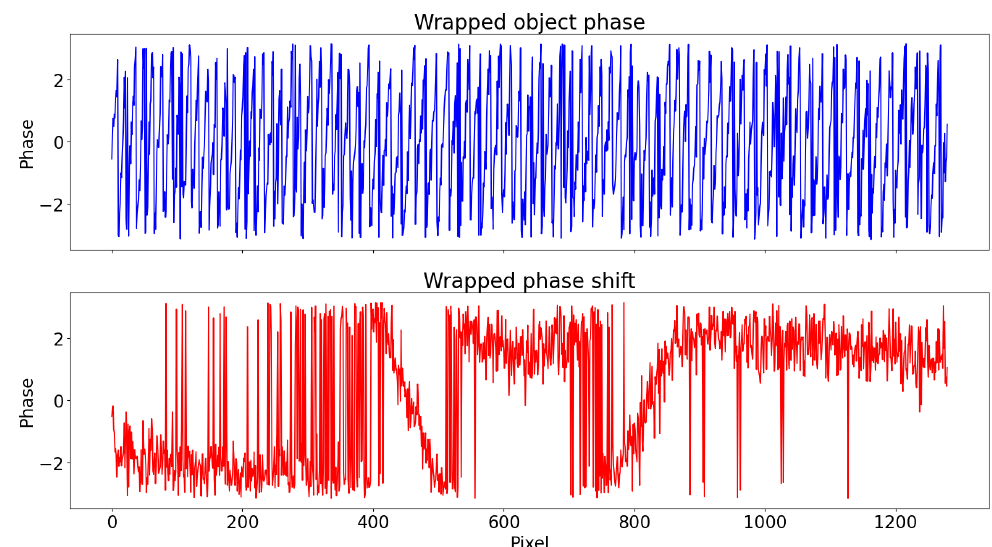
Figure 10. ( Top ) Wrapped phase Φ w and ( Bottom ) phase shift ∆ Φ w at middle row. Unwrapping of Φ w has to manage many more 2 π -jumps.